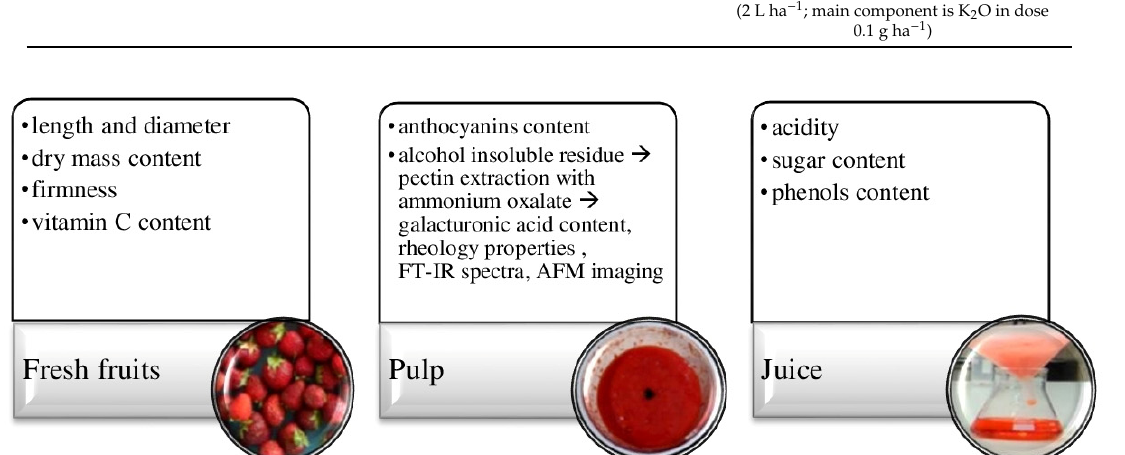
Figure 1. Scheme of quality testing of strawberries.